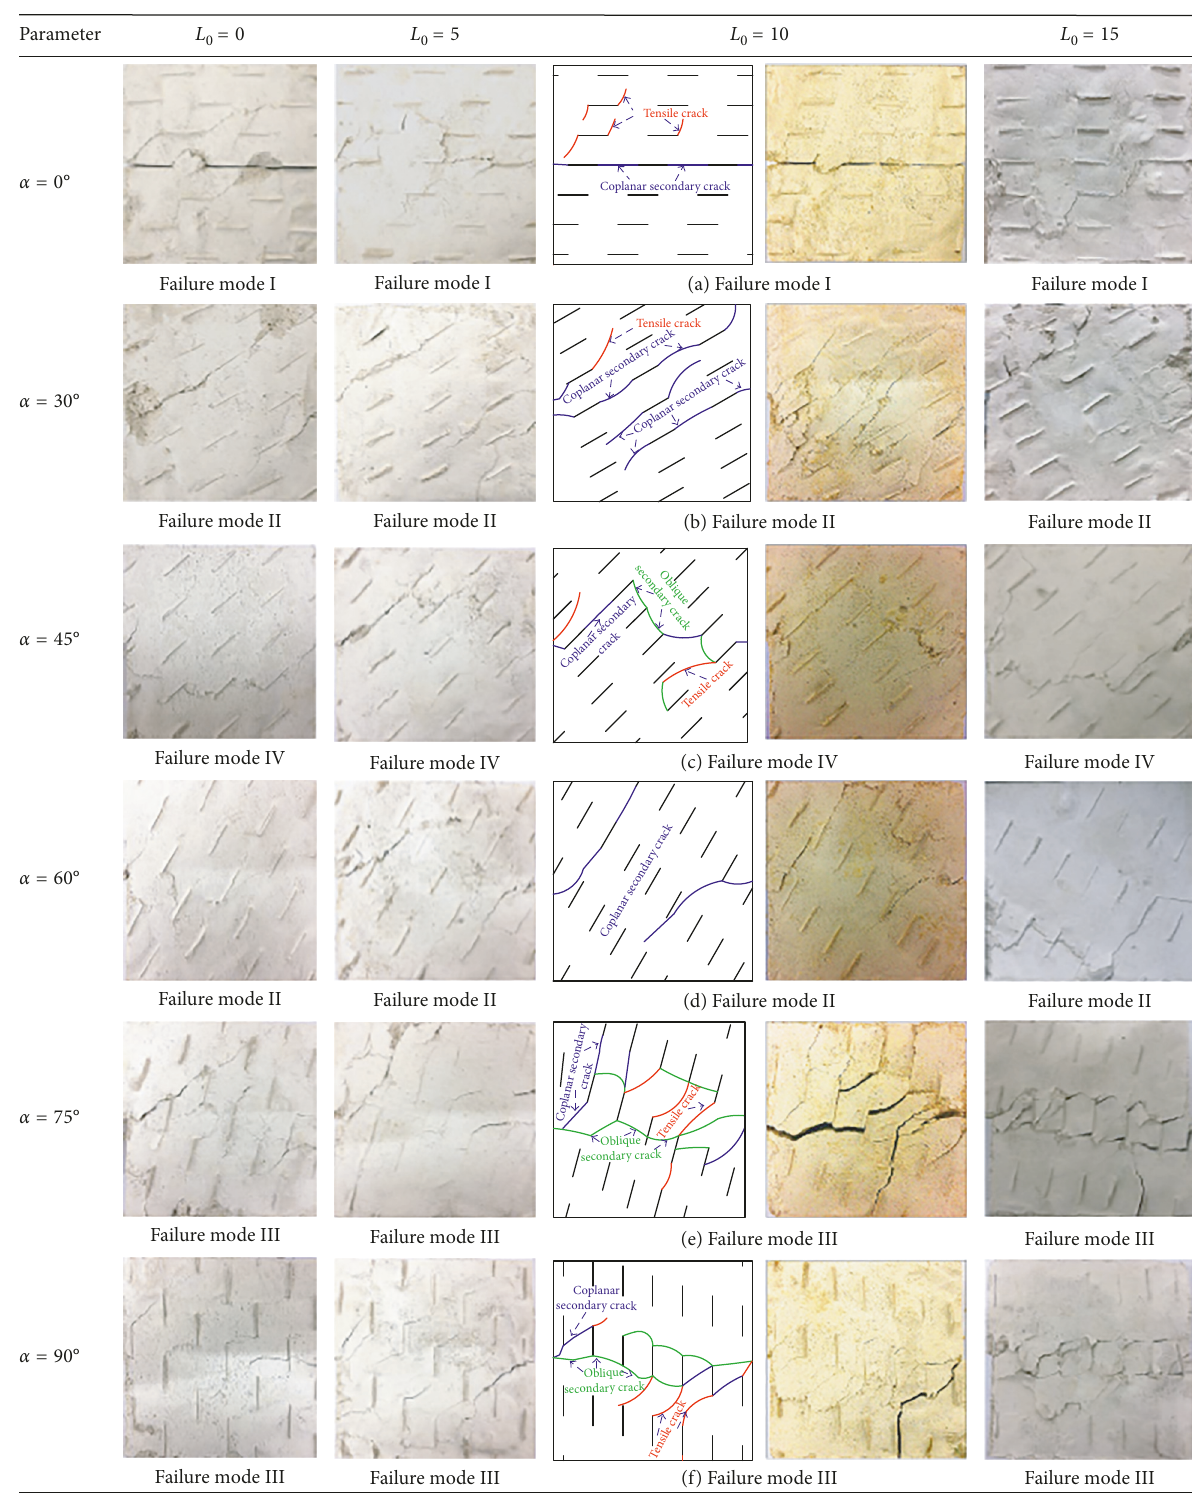
Figure 5: Failure modes of jointed rock